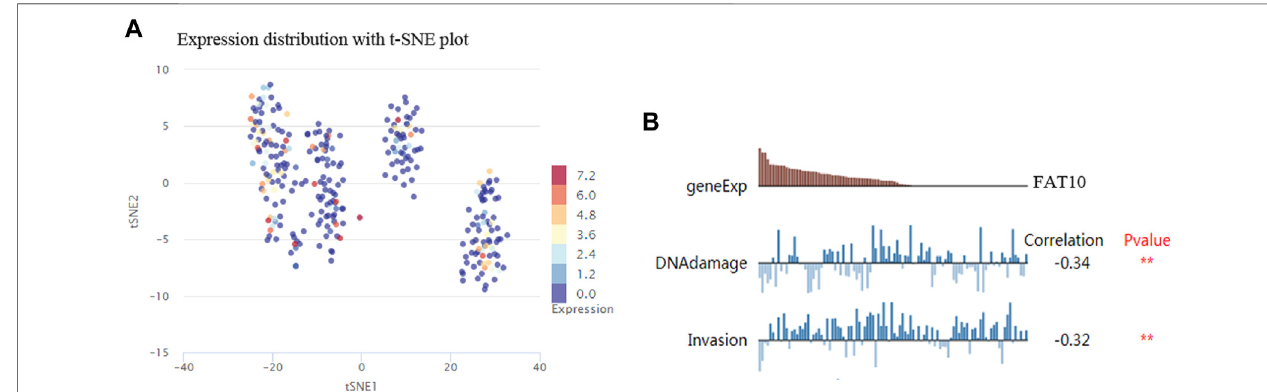
Frontiers in Molecular Biosciences |